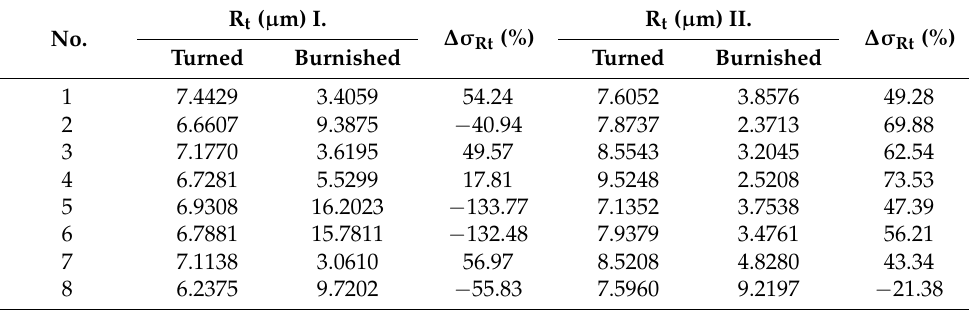
Table 7. The measured values and the calculated improvement ratios for R t .